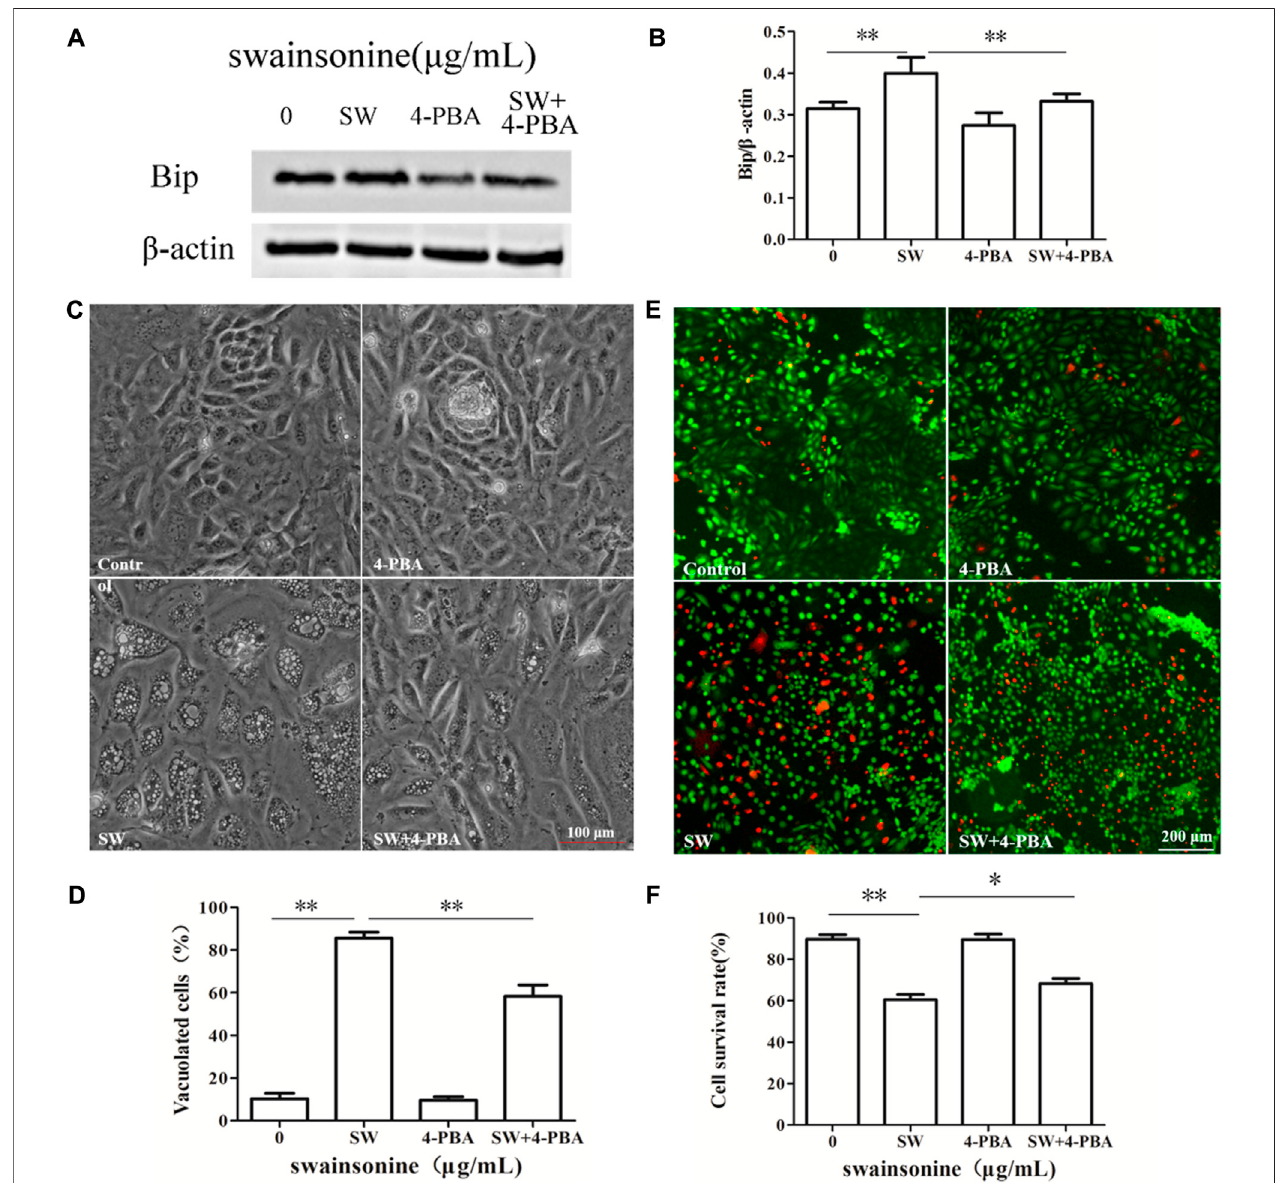
FIGURE 8 | Effects of 4-PBA on SW-induced cytoplasmic vacuolization and cell death. RTECs were pretreated with 4-PBA at the indicated concentrations for 4 h and further treated with 400 μ g/ml SW for 24 h (A,B) Western blotting was used to analyze the Bip protein level changes in the presence of 4-PBA. Three independent experiments were performed. * p < 0.05, ** p < 0.01 (C,D) Inverted microscopic images of RTECs treated with SW (400 μ g/ml) in the presence of 4-PBA. Morphometric analysis of vacuoles was performed with three different areas and the percentage of SW-induced vacuolated cells was calculated (E,F) Cellular viability was assessed using Live and Dead TM Viability/Cytotoxicity Assay Kit. Analyze the number of living (green spots) and dead cells (red spots) in three different areas of control and SW-treated cells and the ratios were calculated.